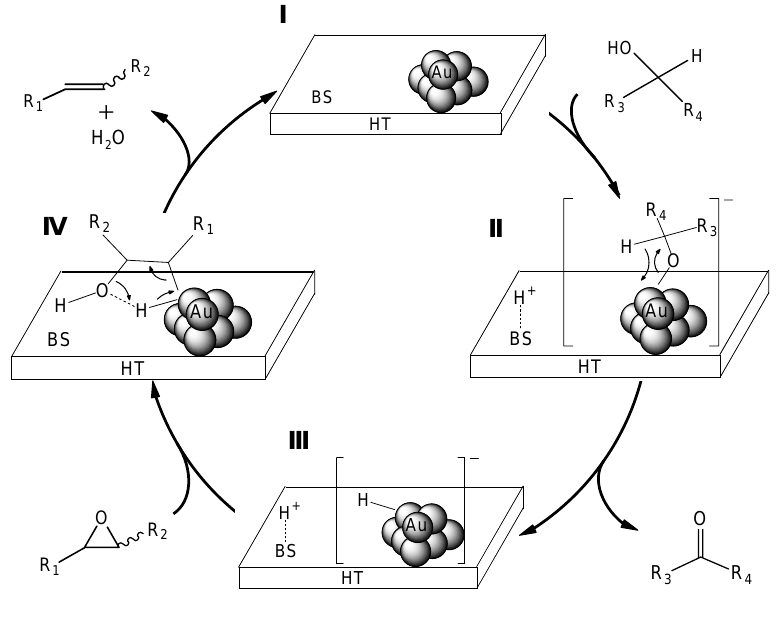
Figure 5. Plausible Reaction Path for the Au/HT-catalyzed Deoxygenation of an Epoxide through the Concerted Action between Au NPs and a Basic Site of HT (represented by